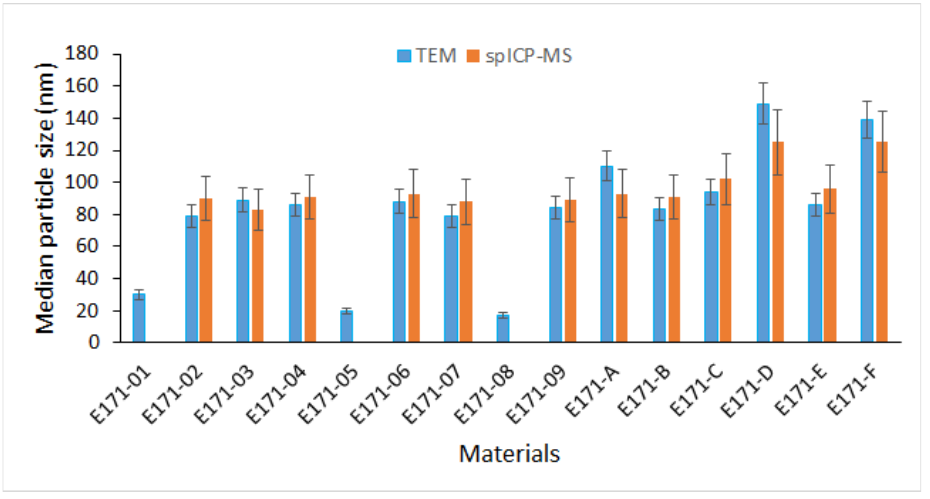
Figure 5. Medians of particle size distributions, expressed as Fmin and ESD for TEM and spICP-MS, respectively, of all 15 E171 materials. For TEM, medians of Fmin were obtained using P1 for pearlescent pigments (E171-01, E171-05, and E171-08) and P6 for the other materials. The error bars represent the expanded measurement uncertainties (Ucx, k = 2), which for TEM were obtained from RTMs NM-100 and NM-103, and for spICP-MS, as shown in Table 4.